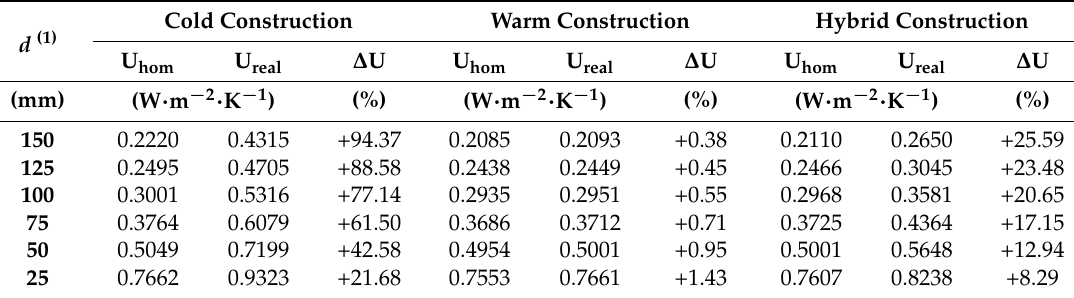
Table 4. Overview of the obtained thermal transmittance